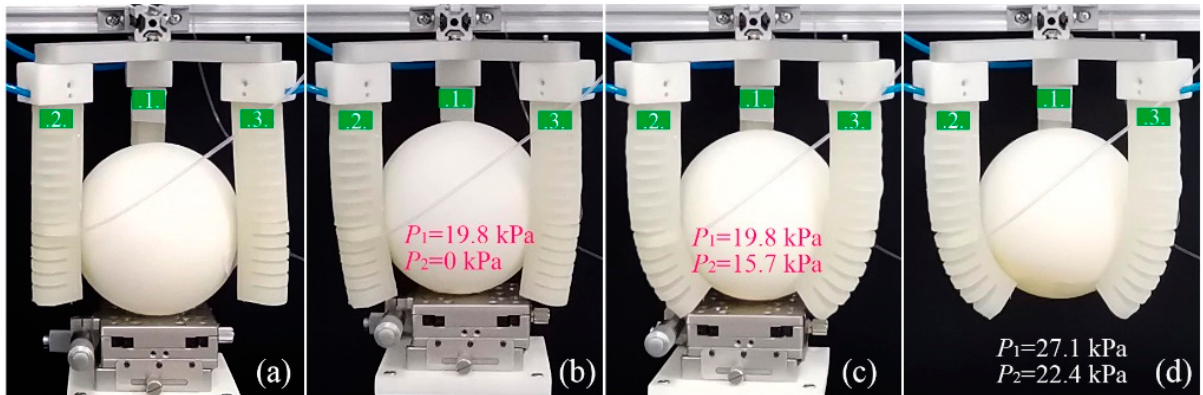
Figure 15. Primary stages of an EG grasping process: ( a ) the original state, ( b ) soft actuators first get in touch with the sphere, ( c ) forming an enveloping grasp with the increase in pressure, and ( d ) realization of a stable EG.